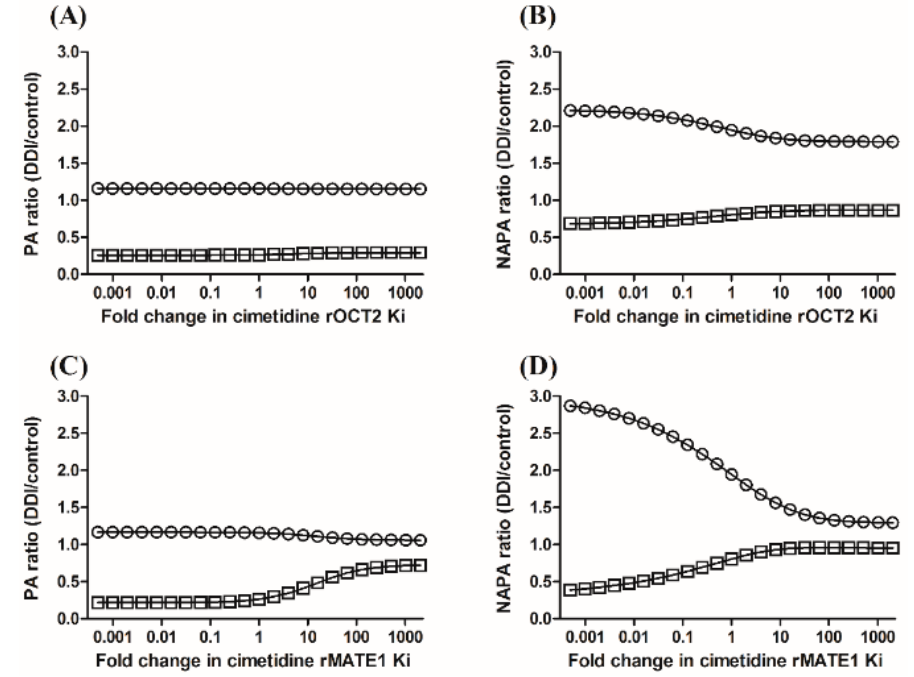
Figure 6. Sensitivities of the PA ratios ( A , C ) and NAPA ratios ( B , D ) of plasma AUC (circles) and urinary recovery (squares) to cimetidine K i values for rOCT2 ( A , B ) and rMATE1 ( C , D ), based on a PBPK model incorporating a semi-mechanistic kidney compartment.